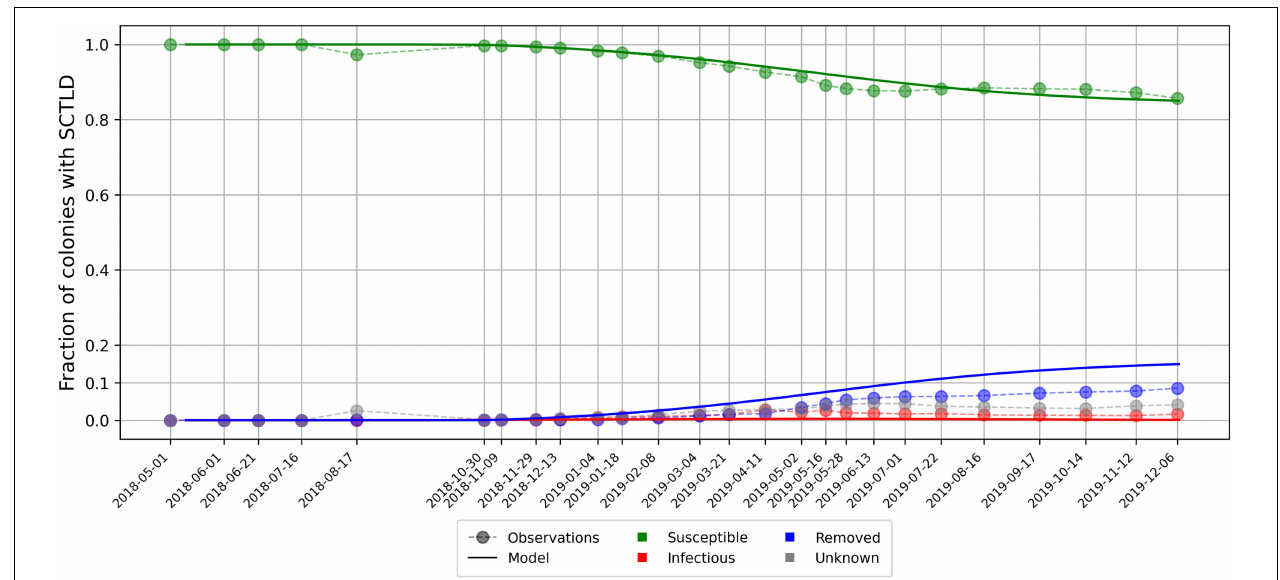
FIGURE 5 | Disease prevalence averaged over all monitored sites over time as modeled by Eq. 4 using calibrated transmission and removal parameters β (cid:48) 0 = 1 6 . 45 days - 1 and σ = 1 6 . 99 days - 1